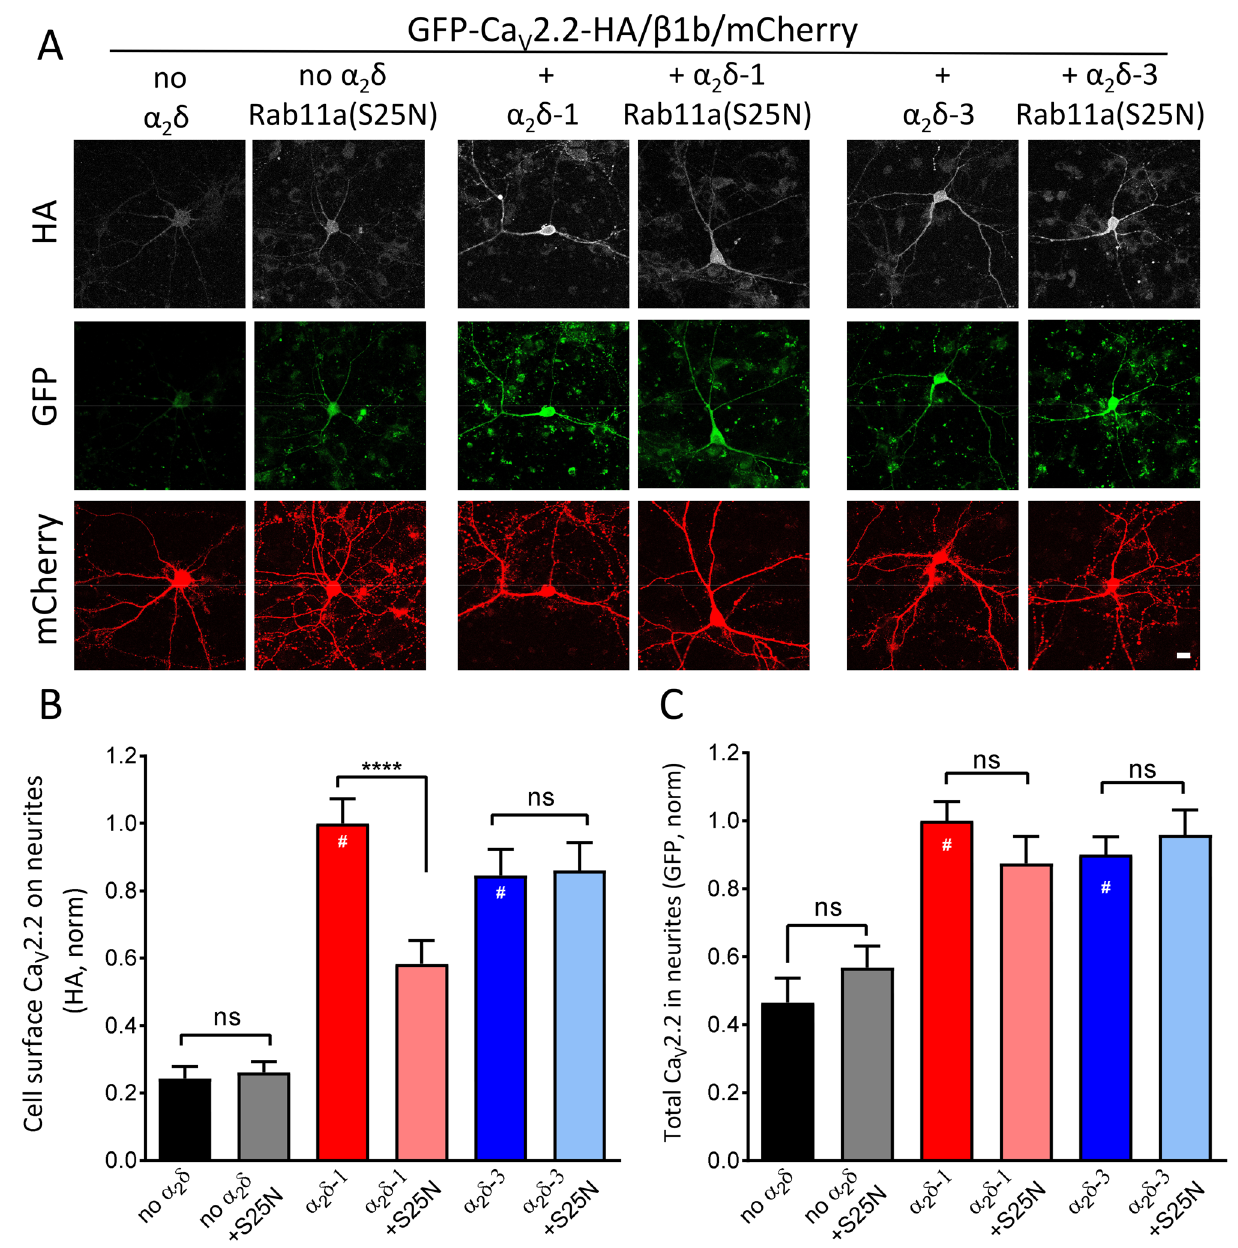
Figure 3. Rab11a(S25N) reduces plasma membrane-inserted Ca V 2.2 in hippocampal neurites when expressed with α 2 δ-1 but not without α 2 δ or with α 2 δ-3. ( A ) Confocal images of rat hippocampal pyramidal neurons expressing GFP- Ca V 2.2-HA/β1b/mCherry control, + Rab11a(S25N), α 2 δ-1, α 2 δ-1 + Rab11a(S25N), α 2 δ-3 or α 2 δ-3 + Rab11a(S25N). Scale bar applies to all images = 20 μm. Top row, HA immunostaining in non-permeabilised neurons to measure cell surface Ca V 2.2; middle row, GFP to determine total Ca V 2.2 expression; bottom row, mCherry (transfection marker) expression. ( B ) Normalized mean cell-surface GFP-Ca V 2.2-HA, determined from HA staining in non-permeabilised neurons, in the processes of pyramidal rat neurons expressed with β1b/mCherry for control (black), Rab11a(S25N) (grey), α 2 δ-1 (red), α 2 δ-1 + Rab11a(S25N) (pink), α 2 δ-3 (blue) or α 2 δ-3 + Rab11a(S25N) (light blue). Statistical significance was determined using one-way ANOVA (F = 16.32, P < 0.0001) and Sidak’s multiple comparison post hoc tests; ns, P > 0.999 for both control vs S25N and α 2 δ-3 vs α 2 δ-3 + S25N; ****, P < 0.0001. Significance vs no α 2 δ control: #, P < 0.0001 for both α 2 δ-1 and α 2 δ-3. ( C ) Normalized mean total GFP-Ca V 2.2-HA (determined from GFP density) in the processes of pyramidal rat neurons expressed with β1b/mCherry for control (black), Rab11a(S25N) (grey), α 2 δ-1 (red), α 2 δ-1 + Rab11a(S25N) (pink), α 2 δ-3 (blue) or α 2 δ-3 + Rab11a(S25N) (light blue). Statistical significance was determined using one-way ANOVA (F = 8.74, P < 0.0001) and Sidak’s multiple comparison post hoc tests; ns, P = 0.925 for control vs S25N; P = 0.559 for α 2 δ-1 vs α 2 δ-1 + S25N; P = 0.974 for α 2 δ-3 vs α 2 δ-3 + S25N. Significance vs no α 2 δ control: #, P < 0.0001 for both α 2 δ-1 and α 2 δ-3. For ( B ) and ( C ), between 2–5 neuronal processes were measured and averaged per cell, 10–15 cells per condition per experiment, for a total of 3 transfections. Total cell numbers for each condition: control (n = 30 cells), Rab11a(S25N) (n = 19 cells), α 2 δ-1 (n = 51 cells), α 2 δ-1 + Rab11a(S25N) (n = 42 cells), α 2 δ-3 (n = 46) and α 2 δ-3 + Rab11a(S25N) (n = 40 cells). Normalized mean fluorescence intensity per neuron was pooled from three separate experiments and data are plotted ± SEM